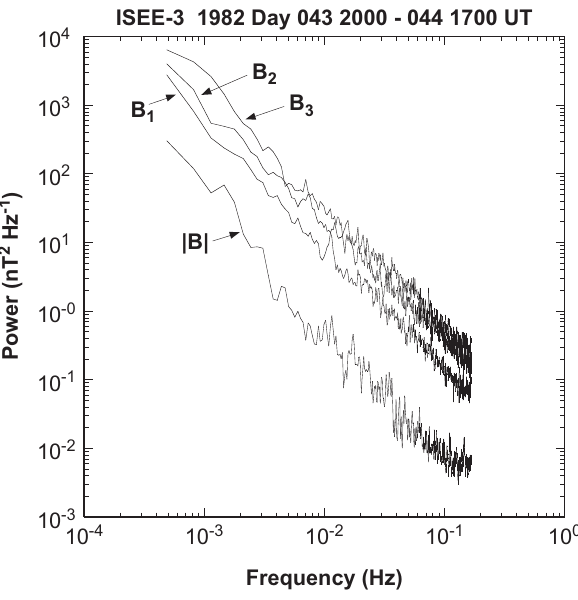
Fig. 7. Magnetic power spectra for the 12 February 1982 event. The two transverse components are indicated by the subscripts 1 and